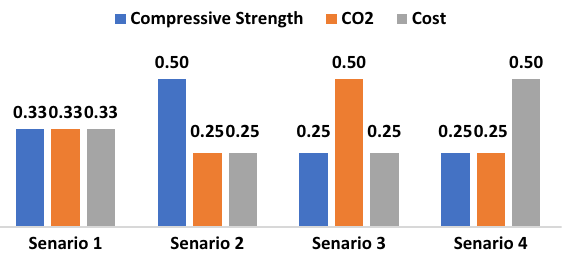
Figure 8. The four scenarios for the relative weights of the optimization criteria.